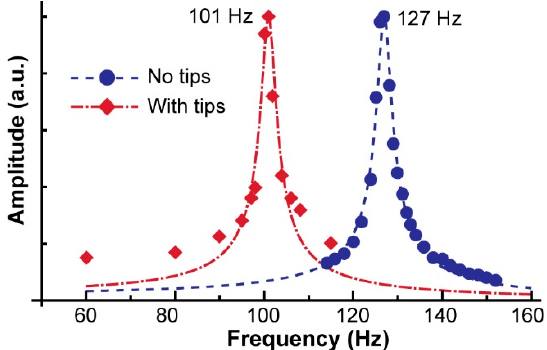
Figure 7. Frequency response of the system. The series in blue shows the frequency response of the piezo-tweezer system. The orange series is for the system with the attached tips. The resonant frequencies of 101 Hz and 127 Hz with and without tips, respectively, are indicated.